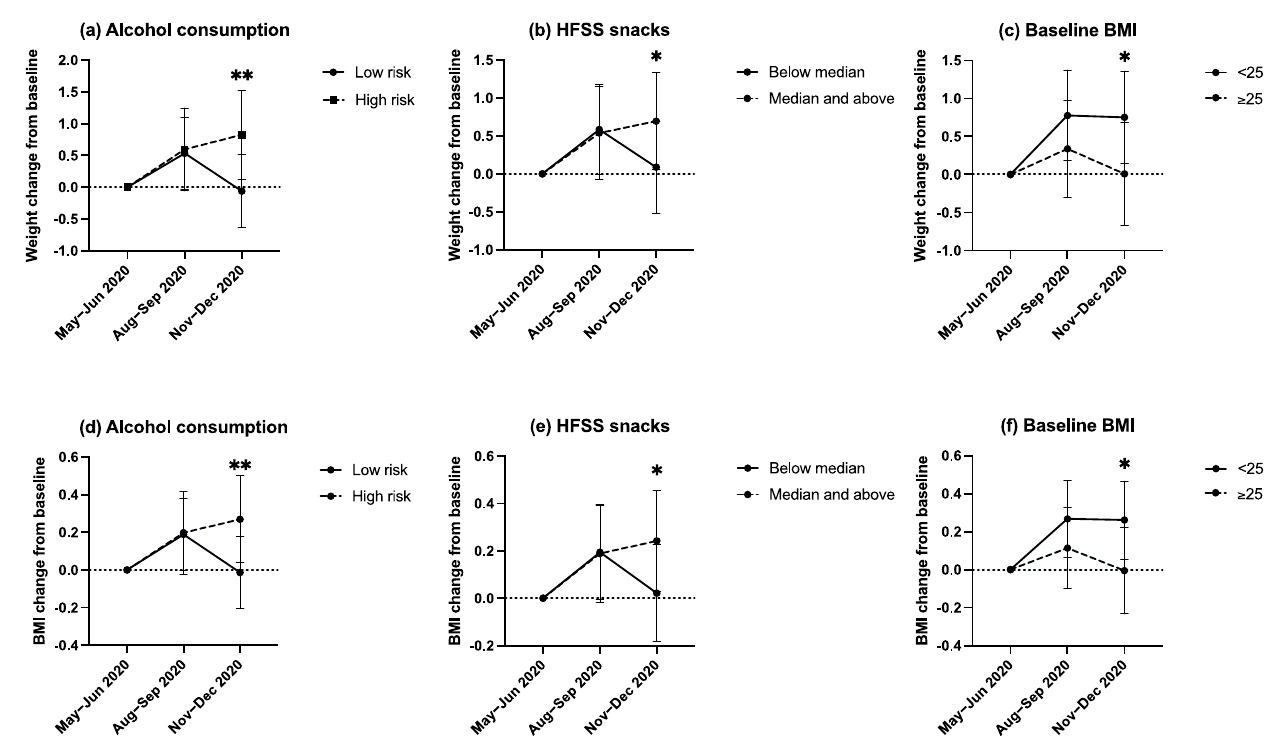
Figure 2. Graphical representations of the time-varying associations of alcohol consumption ( a ), HFSS snacks intake ( b ) and baseline BMI ( c ) with weight change at 3-months (August–September 2020) and 6-months follow-up (November–December 2020). Graphical representations of the time-varying associations of alcohol consumption ( d ), HFSS snacks intake ( e ) and baseline BMI ( f ) with BMI change at 3-months (August–September 2020) and 6-months follow-up (November–December 2020). * Denotes pairwise comparisons between categories were significant at the 0.05 level. ** Denotes pairwise comparisons between categories were significant at the 0.005 level. Median HFSS snacks intake was 34.5 and 40.0 portions per month at 3-months (August–September 2020) and 6-months follow-up (November–December 2020), respectively.